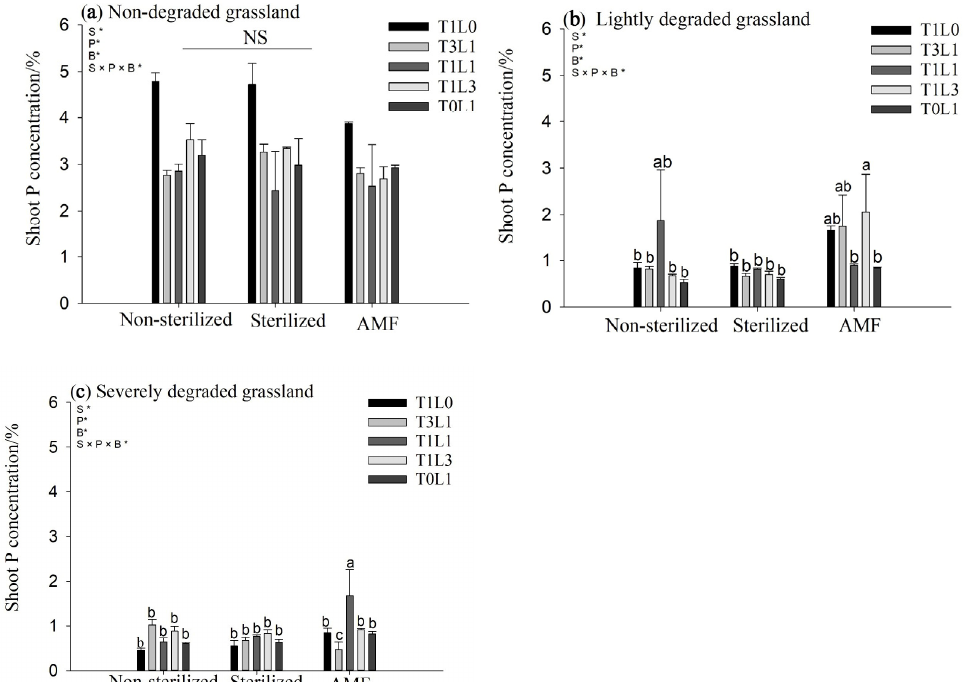
Figure 4. Effects of different treatments on shoot P content. ( a ) Effects of soil type (S), planting ratio (P) , biological treatment (B) and their interactions (S × P × B) on shoot P concentration in non-degraded grassland soil ( b ) Effects of soil type (S), planting ratio (P) , biological treatment (B) and their interactions (S × P × B) on shoot P concentration in lightly degraded grassland soil. ( c ) Effects of soil type (S), planting ratio (P) , biological treatment (B) and their interactions (S × P × B) on shoot P concentration in severely degraded grassland soil. Different letters indicate the significant differences among treatments ( p < 0.05). * p < 0.05, p < 0.1 indicate the significance level of each treatment. Note: soil degradation degree (S); planting ratio (P); soil biological treatment (B). T1L0, T3L1, T1L1, T1L3, T0L1 mean planting ratio of T. repens and L. perenne : 1:0, 3:1, 1:1, 1:3, 0:1,